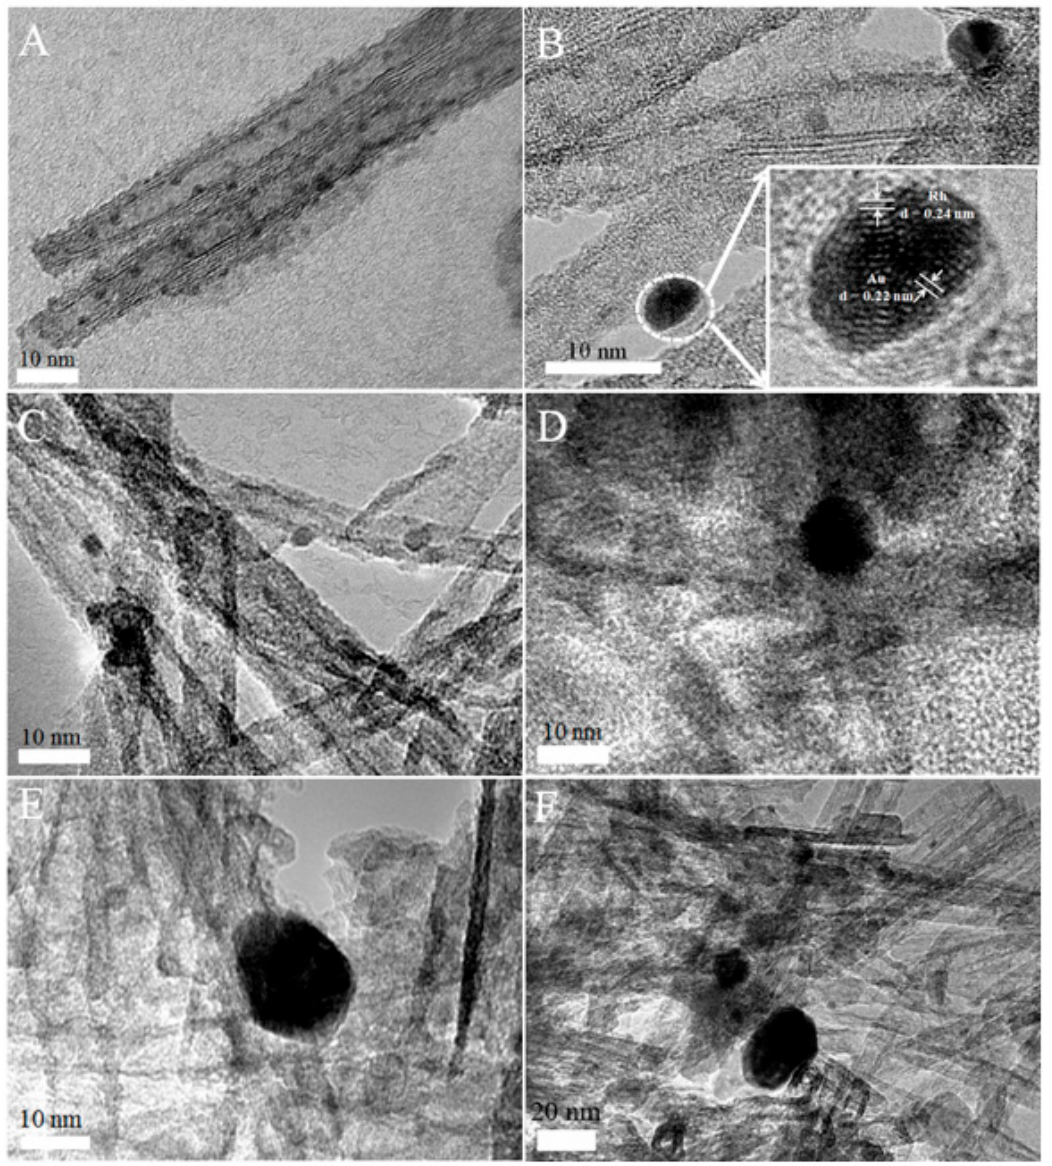
Figure 3. The TEM images of the resultant catalysts: Rh 0.33 /TNTs-1 ( A ); Au 0.52 /Rh 0.32 /TNTs-12 ( B ); Rh 0.31 /Au 0.51 /TNTs-21 ( C ); Au 0.49 /Rh 0.33 /TNTs-22 ( D ); Au 0.50 /Rh 0.32 /TNTs-11 ( E ) and Au 0.52 /Rh 0.32 /TNTs-12* ( F ).